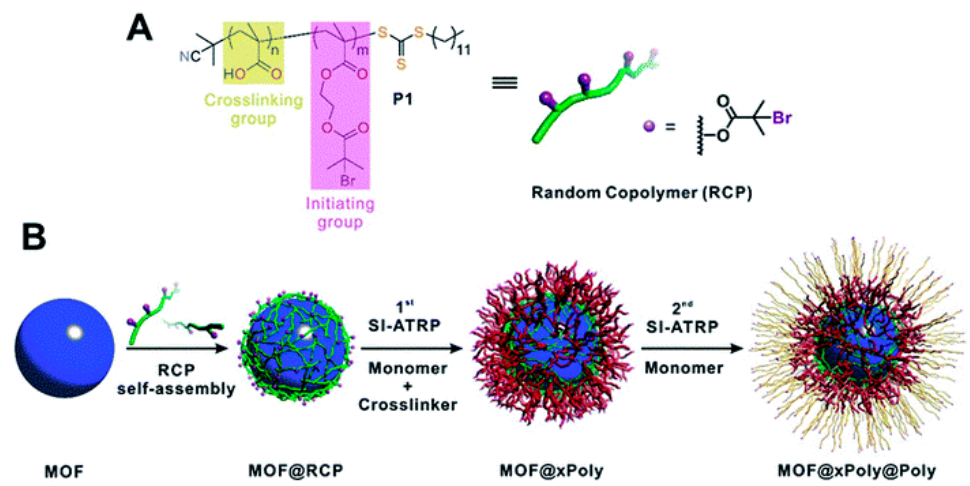
Figure 8. ( A ) Molecular structure of the random copolymer macroinitiator, P1. ( B ) Schematic illustration of typical experimental procedures for growing polymer shells on a MOF particle [94].